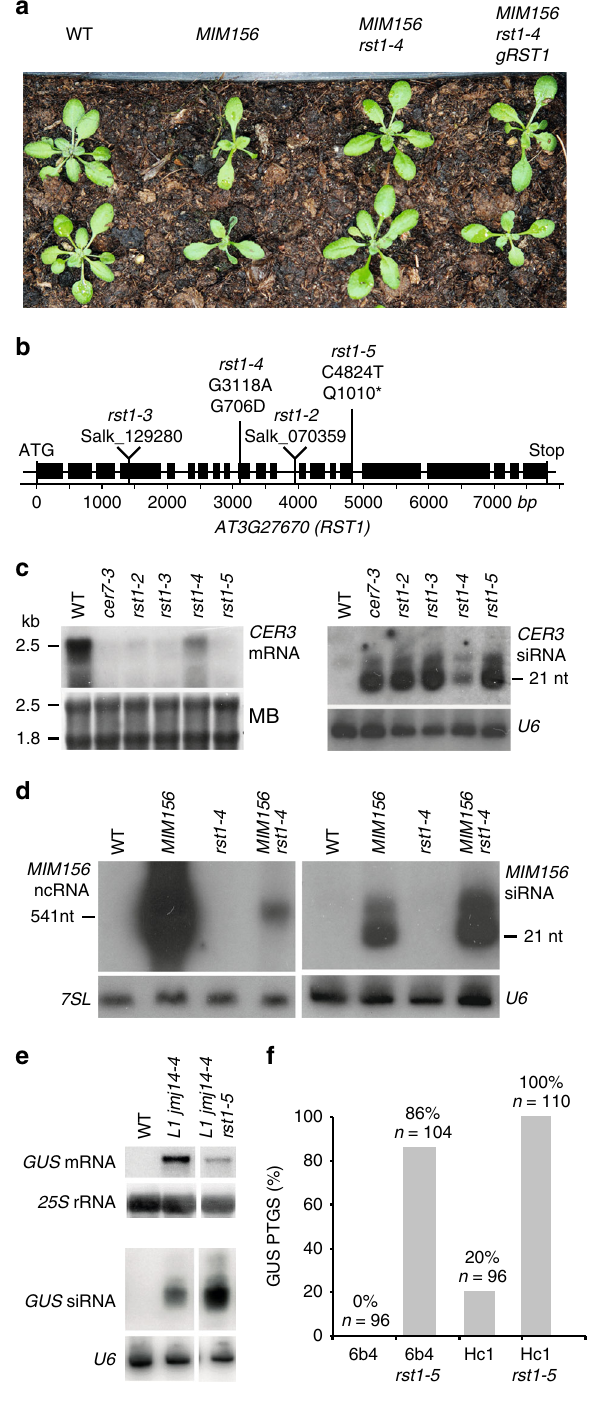
Fig. 2 RST1 suppresses silencing of transgenes. a The rst1-4 mutation suppresses the developmental phenotype induced by a MIM156 transgene. b Diagram of the AT3G27670 gene encoding the RST1 protein. Boxes represent exons, lines represent introns. Triangles indicate the position of the T-DNA insertions in rst1-2 and rst1-3 lines. Vertical lines indicate the point mutations in rst1-4 and rst1-5 . c rst1-4 is a weak allele. Accumulation of the CER3 mRNA (left) and CER3 -derived siRNAs (right) in wild-type (WT), cer7-3 and the four rst1 alleles used in this study shown by RNA blots hybridised with a probe speci fi c to CER3. The methylene blue stain of the membrane (MB) and hybridisation to U6 snRNA are shown as loading controls. d RNA blots showing the accumulation of the full-length MIM156 ncRNA and MIM156-derived siRNAs visualised by hybridisation with a probe speci fi c to the IPS1 backbone of the MIM156 transgene. 7SL RNA and U6 snRNA are shown as loading controls. e RNA blots showing that the rst1-5 mutation results in reduced levels of the GUS mRNA and increased levels of GUS -derived siRNAs in the L1 jmj14-4 background. 25S rRNA and U6 snRNA are shown as loading controls. f The rst1-5 mutation increases S- PTGS frequency in both 6b4 and Hc1 reporter lines. The barplot shows the proportion of plants with silenced GUS expression in the indicated genotypes. The source data are available at [https://doi.org/10.6084/m9. fi gshare.c.4483406]